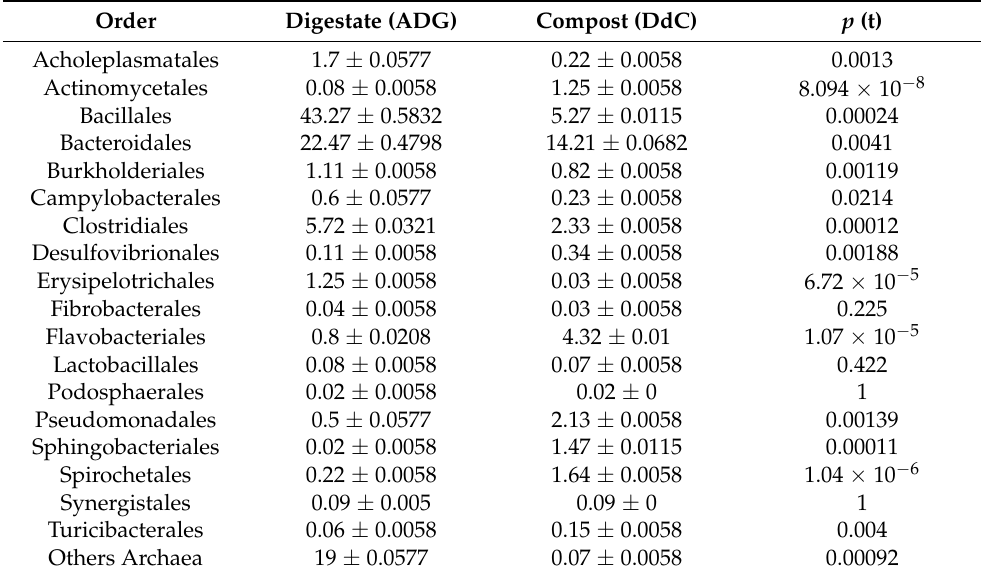
Table 4. Relative abundance of the shared orders in digestate and digestate derived-compost and results of the statistical Student’s t